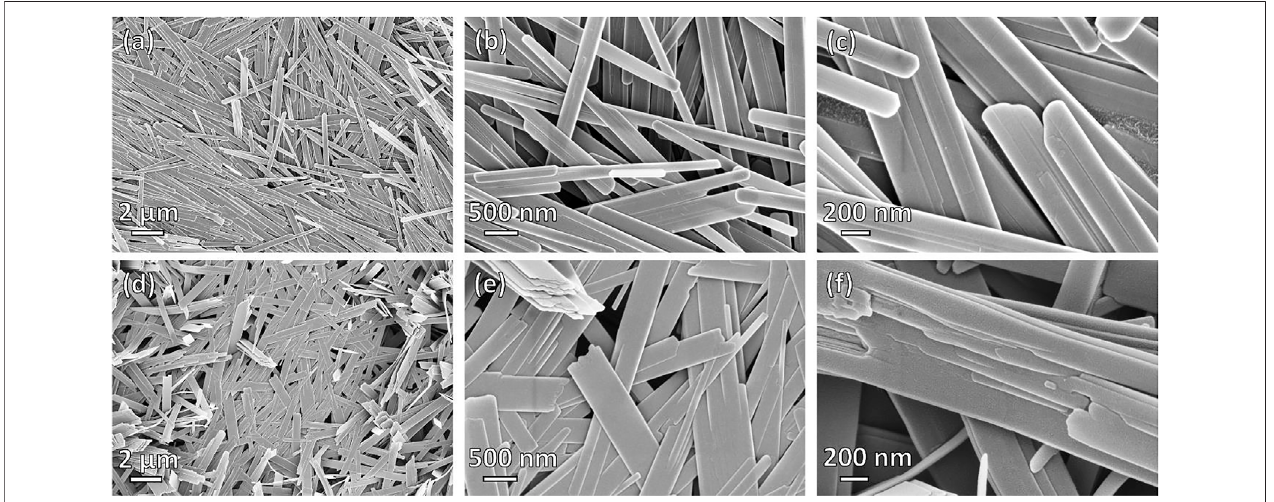
FIGURE 3 | SEM images of the (A – C) α -MoO 3 -ref and (D – F) HT-MoO 3 /C nanobelts (A, D) Low- and (B, C, E, F) high-magni fi cation images are